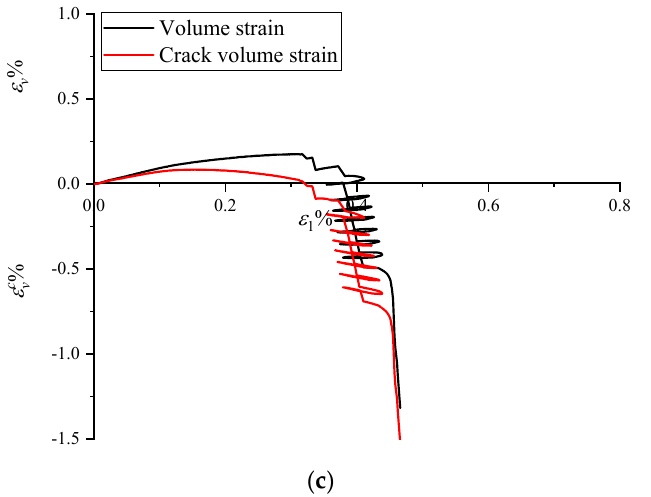
Figure 10. Volumetric strain of cracks under 70% of the UCS: ( a ) Gra70% − 1; ( b ) Gra70% − 2; ( c ) Gra70% − 3.